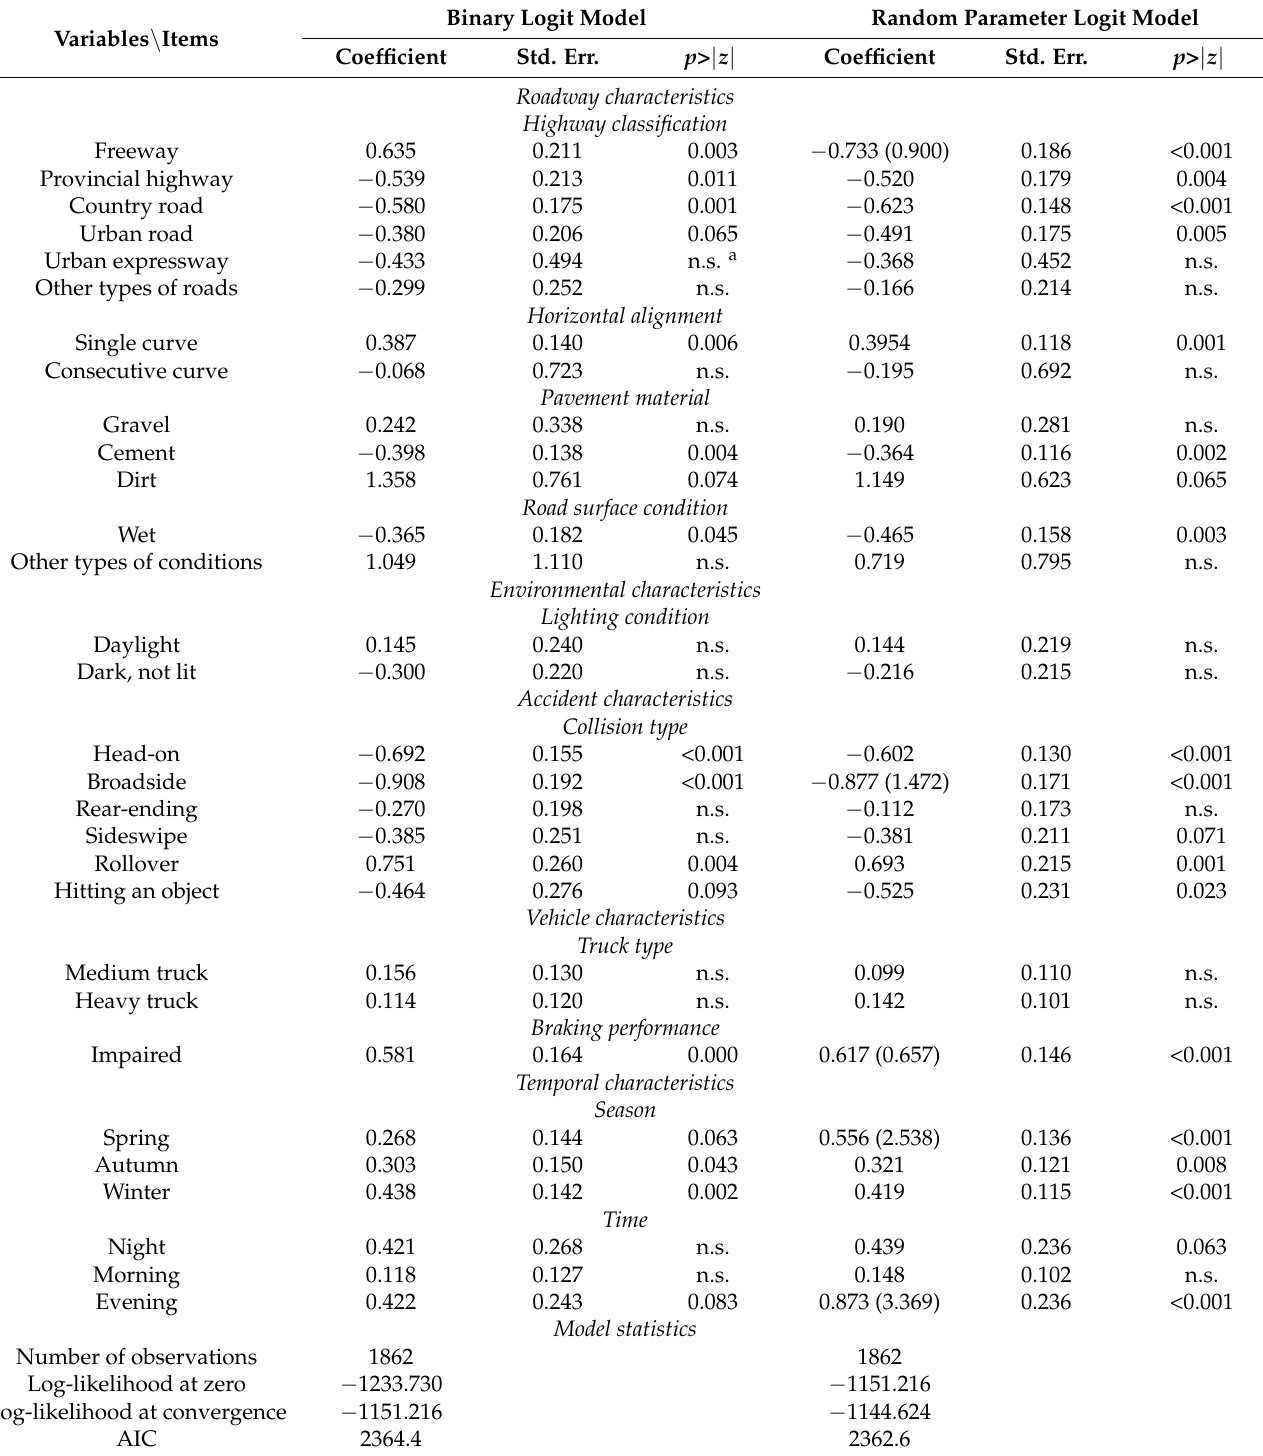
Table 2. Estimated results for the binary logit model and the random parameter logit